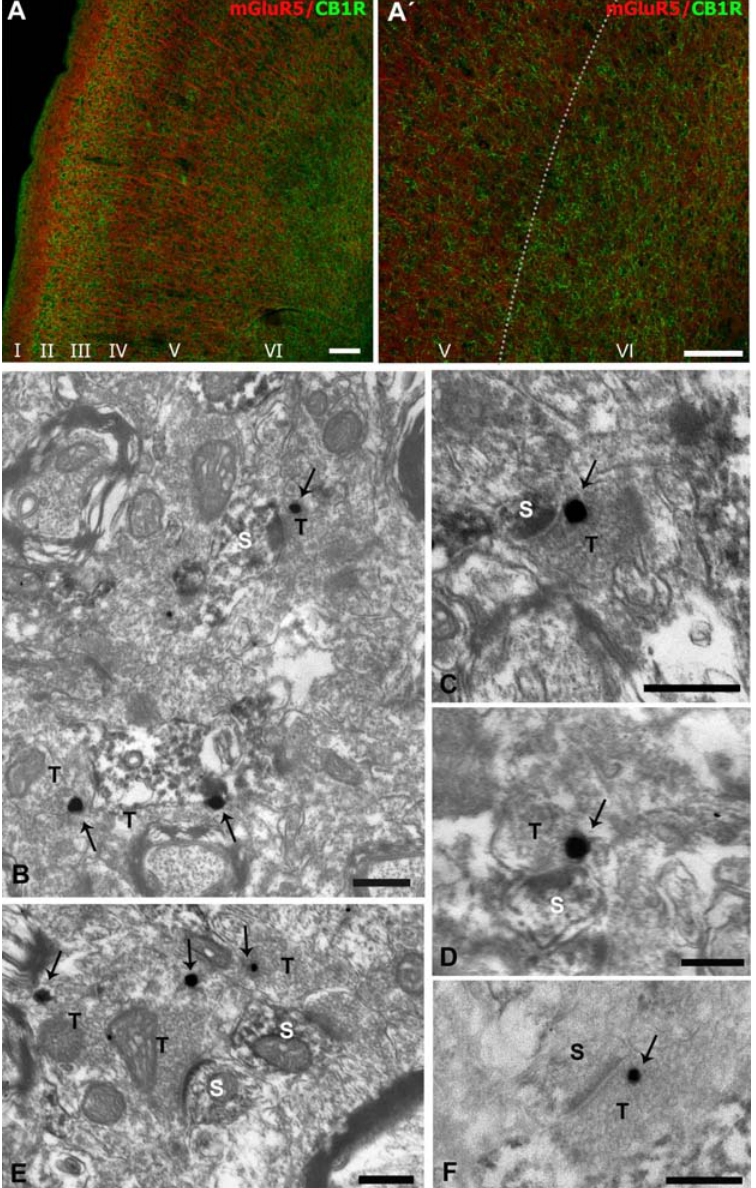
Figure 1. Immunocytochemical localization of mGluR5 and CB1R in the prelimbic prefrontal cortex (prPFC). ( A) Double confocal immunofluorescence showed no colocalization of both proteins. mGluR5 immunoreactivity was distributed in the neuropil throughout cortical layers, but the staining was more evident in apical dendrites of layers V/VI pyramidal neurons heading for the superficial layers. High CB1R immunoreactivity was in layers II/III, deeper part of layer V and throughout layer VI (A: enlargement of A). The lack of CB1R labeling showed mGluR5 immunoreactivity in layers I, IV and in the upper part of layer V. (B–F). Electron microscopy of the localization of mGluR5 (DAB immunoreaction product) and CB1R (silver-intensified gold particles) in prPFC cortical layers V/VI. mGluR5 immunoreactivity was in dendritic profiles and spines (s). Typically, CB1R immunopositive synaptic terminals (T) made asymmetric synapses with mGluR5-immunoreactive dendritic spines (s). Note metal particles localizing CB1R (arrows) at perisynaptic and extrasynaptic sites relative to presynaptic membrane specializations of axonal synaptic boutons. Scale bars in A,A’: 100 m m; B,C,E,F: 0.33 m m; D:0.20 m m.